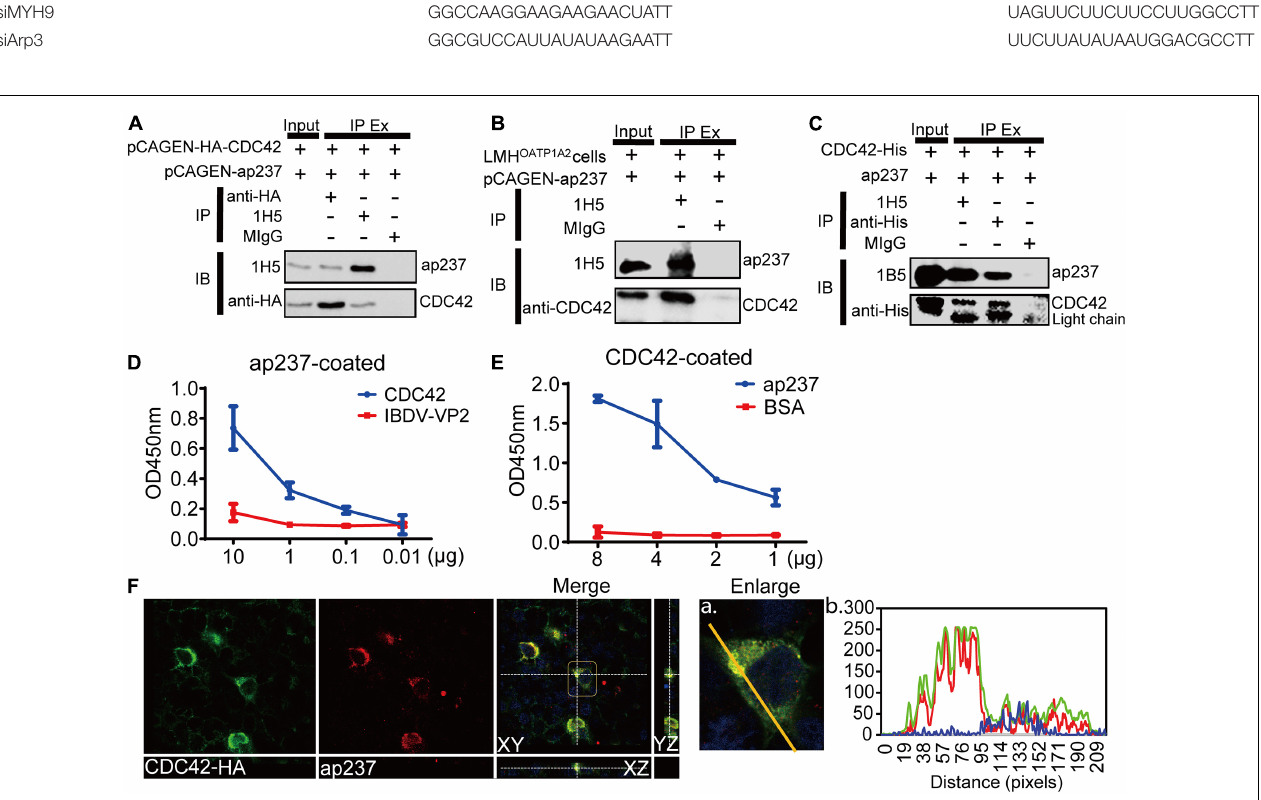
FIGURE 1 | CDC42 interacts with the truncated capsid protein of avian HEV (designated ap237). (A) Co-IP of ap237 and exogenous HA-tagged CDC42 (HA-CDC42) in HEK 293T cells. HEK 293T cells were co-transfected with pCAGEN-ap237 and pCAGEN-HA-CDC42. The lysed cells were immunoprecipitated using anti-HA mAb, 1H5 mAb, and normal mouse IgG (MIgG), respectively, and then immunoblotted with either 1H5 mAb or anti-HA mAb. MIgG was set as a blank control. (B) Co-IP of ap237 and endogenous CDC42 in LMH OATP1A2 cells. 1H5 mAb was used to detect ap237 and Rabbit anti-CDC42 pAb to detect endogenous CDC42. (C) CDC42-His directly interacting with ap237 was determined by pull-down assay using anti-His and 1H5 mAb. The content of “the input” group was about 6.7% of the total proteins. (D,E) Confirmation of direct interaction between CDC42 and ap237 by indirect ELISA with ap237 as coated antigen (D)